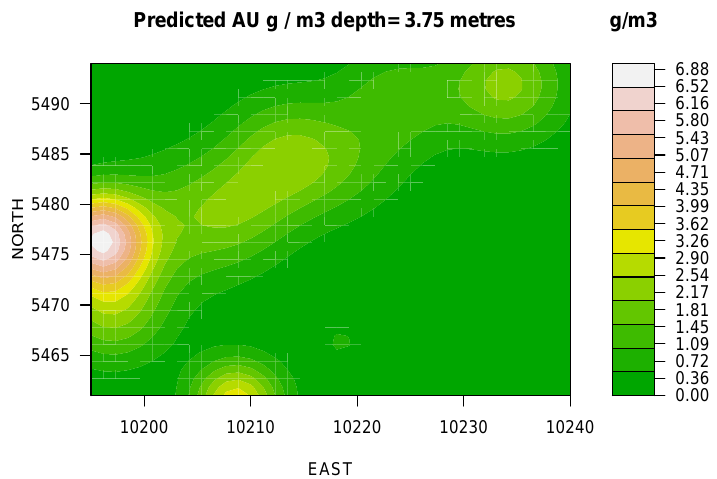
Figure 3. Production target favorability map at depth of 3.75 m in Au g/m 3 . Stable trend identified, the modeled indicates significant geometrical changes accompanied by the mean and median displacements.